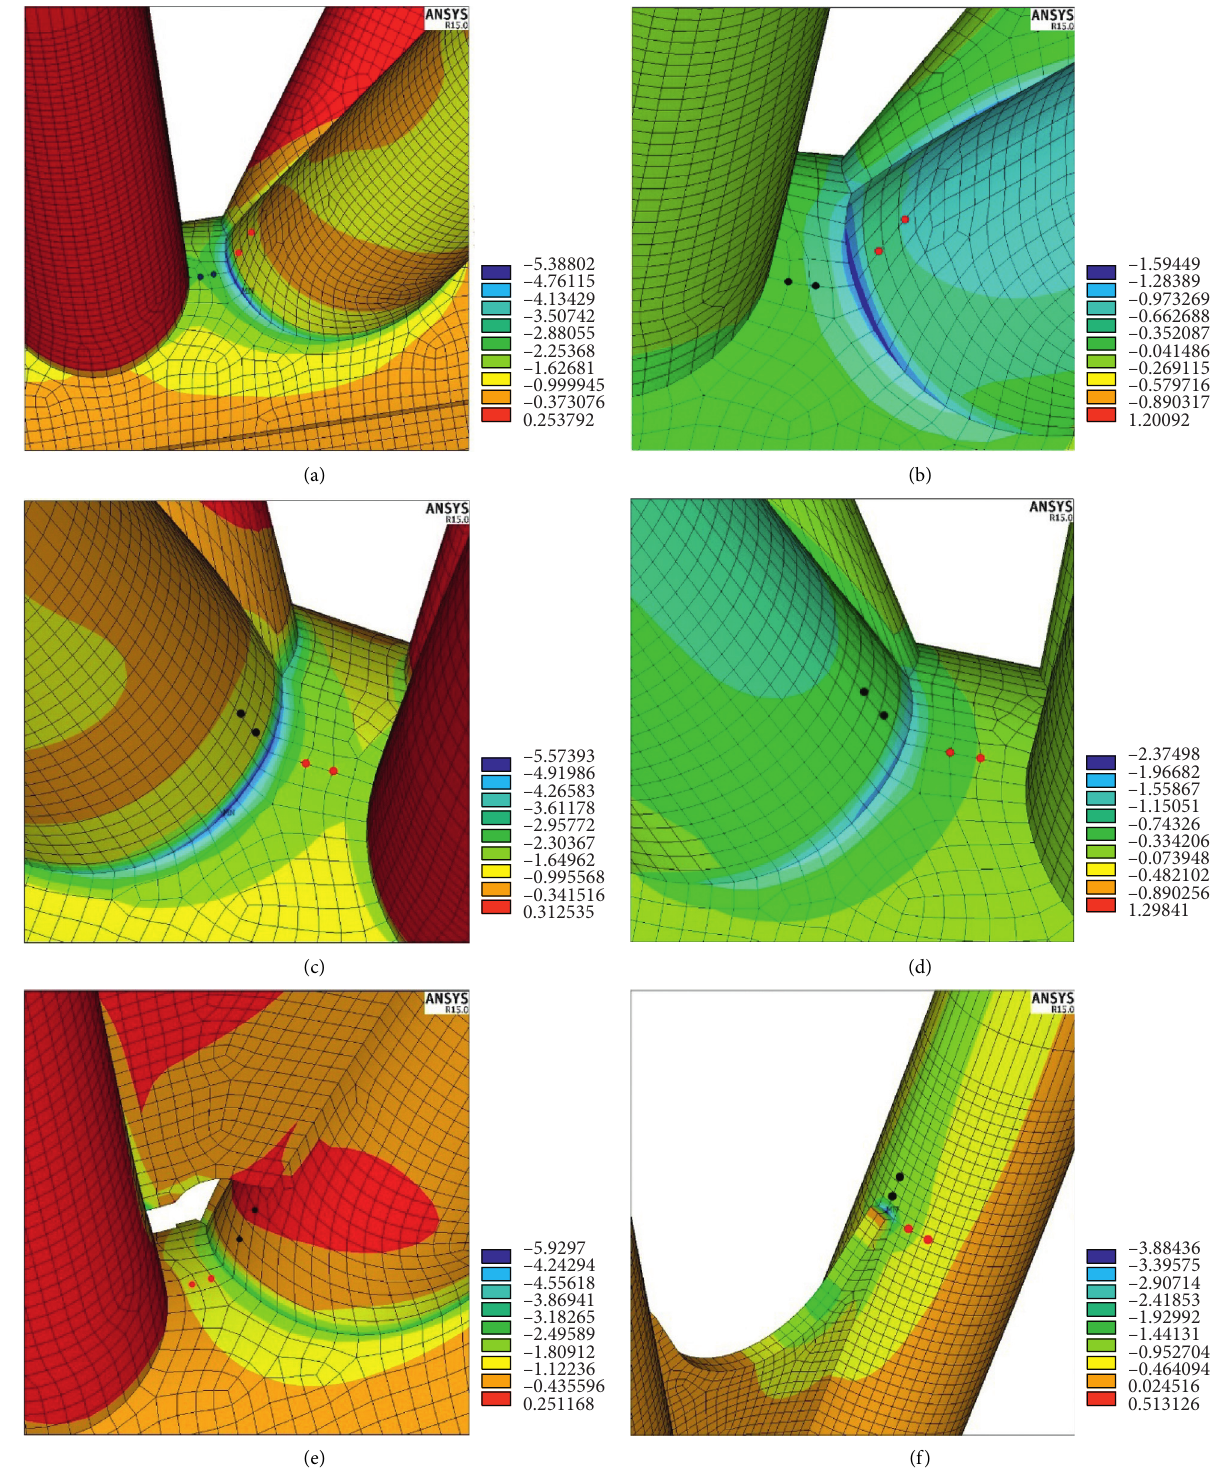
Figure 5: SCF calculation zones for the two-planar overlapped KT-joint: (a) axial and (b) IPB cases (2 and (d) IPB cases (3 ″ brace gap without brackets), and (e) axial and (f) IPB cases (2 ″ brace gap with